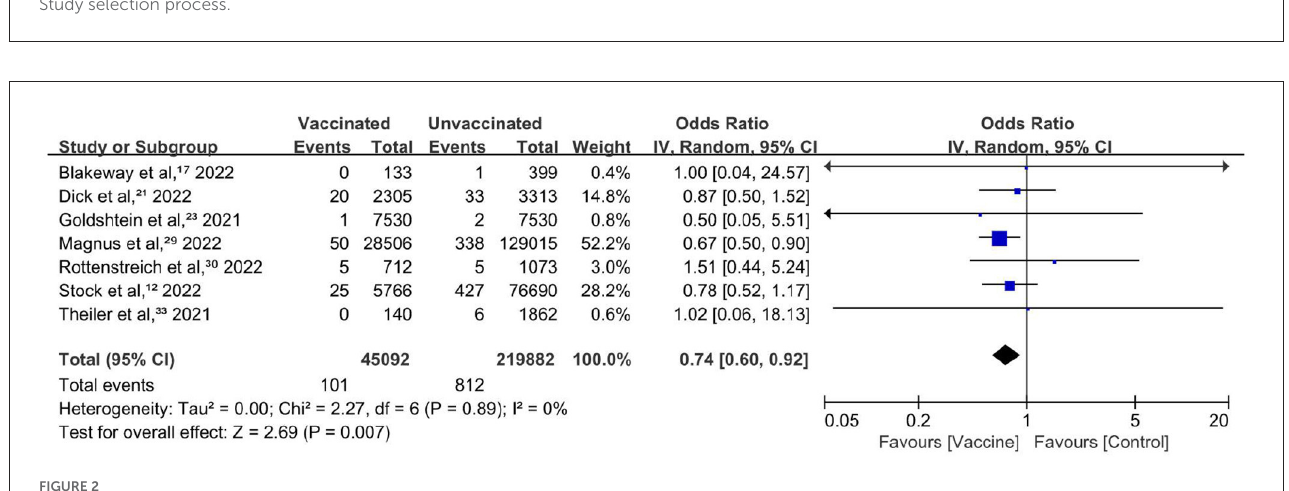
FIGURE1 Study selection process.